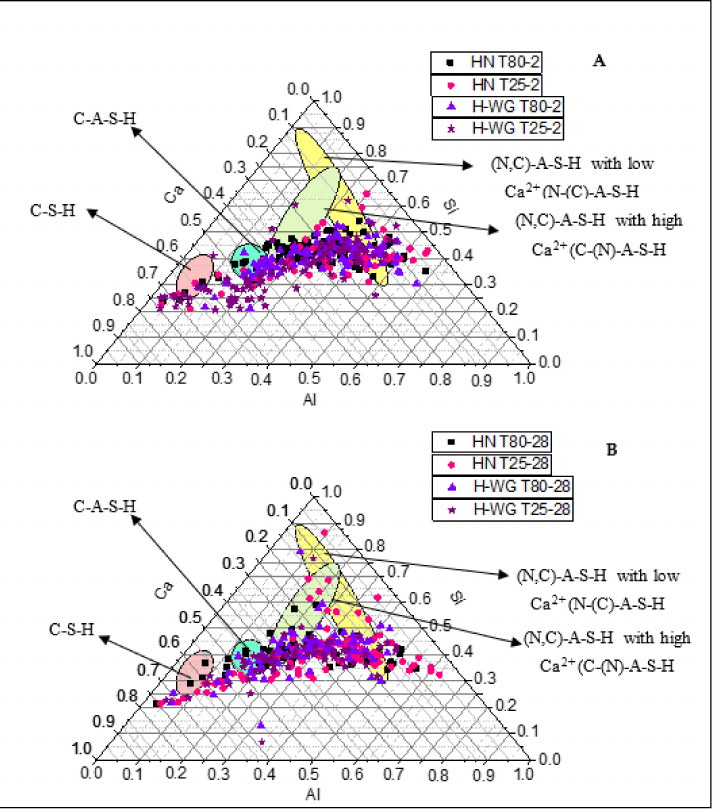
Figure 3. Ca-Si-Al ternary diagrams for ( A ) 2 days and ( B ) 28 days of HN T25, HN T80, H-WG T25 and H-WG T80